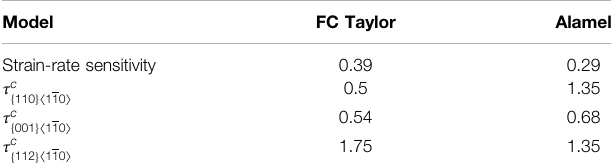
TABLE 4 | Case of AA6082, T (cid:1) 500 ° C. The best- fi t relative critical resolved shear stress (CSSR) for the three nonoctahedral slip systems considered in the texture optimization for FC Taylor and Alamel,